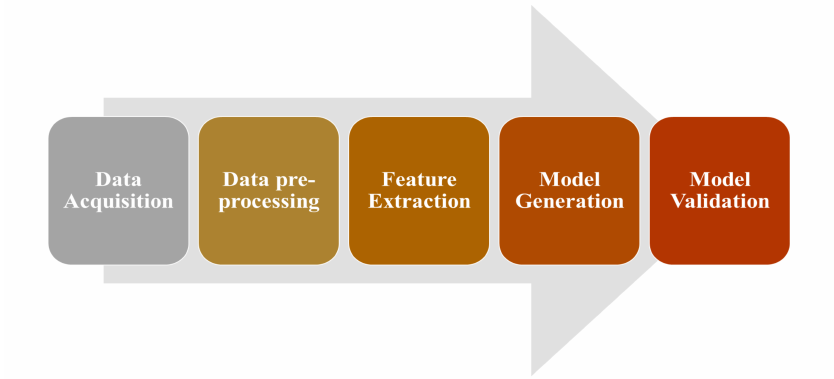
Figure 4. General methodology to apply machine learning or deep learning techniques for classifica- tion